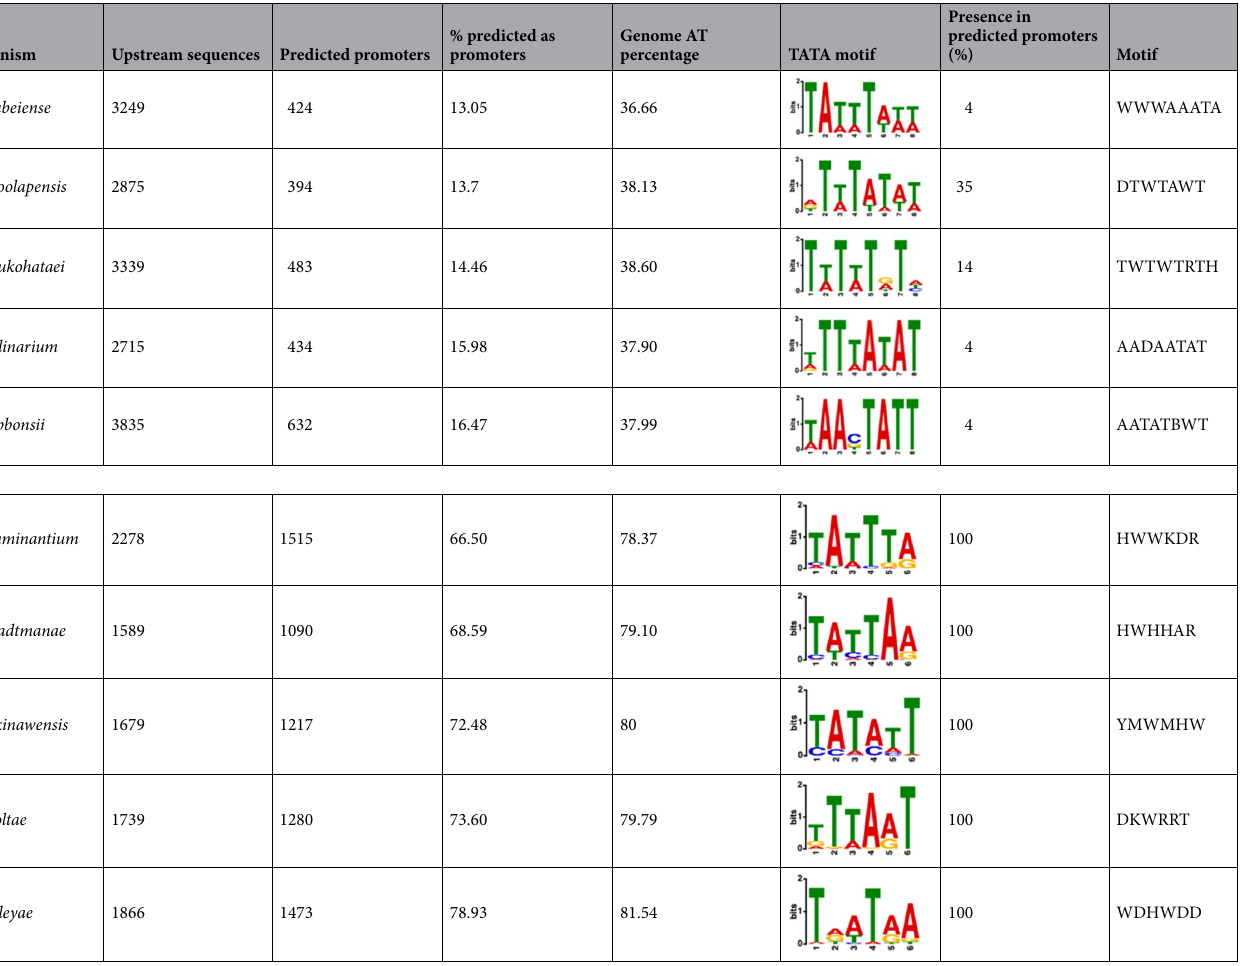
Table 3. Characterization of highest and lowest AT containing upstream regions. We show the: (i) five first archaea our model most predicted promoters for, and; (ii) the five last organisms with promoters associated to. We show the number of upstream sequences deposited for each organism in RSAT, the number and percentage of original sequences predicted as promoters, and the AT nucleotide composition. Additionally, we have submitted the identified promoters to the MEME suite to capture the basal TFBSs, a process which returns the TATA element of each organism, the IUPAC motif, upon which we have scanned our sequences to discover their